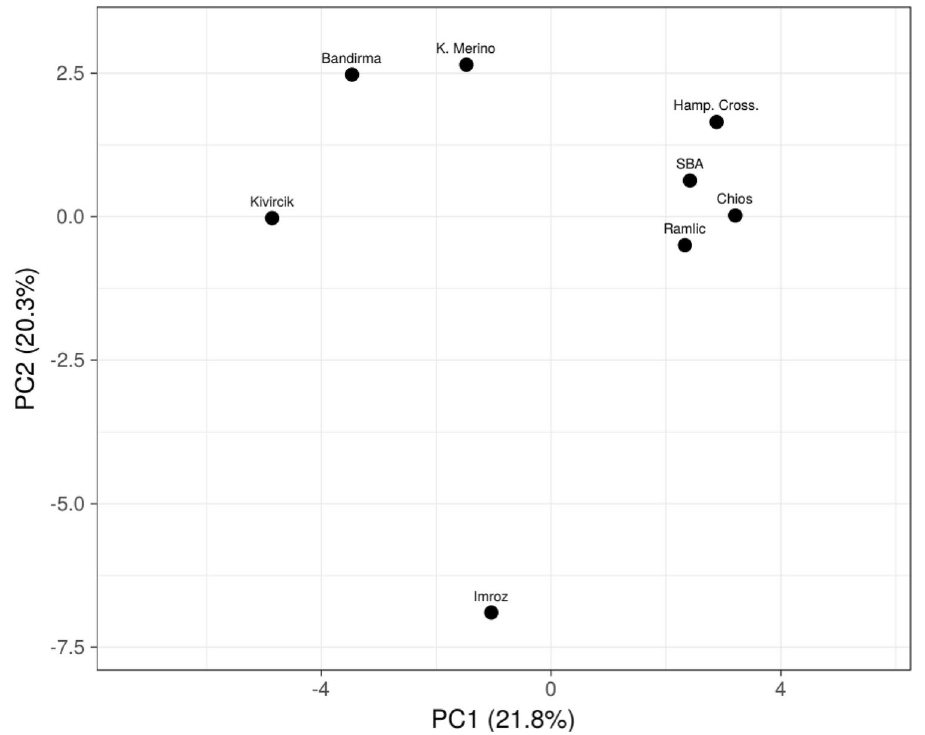
Figure 2. Principal components plot of DRB1 haplotypes according to